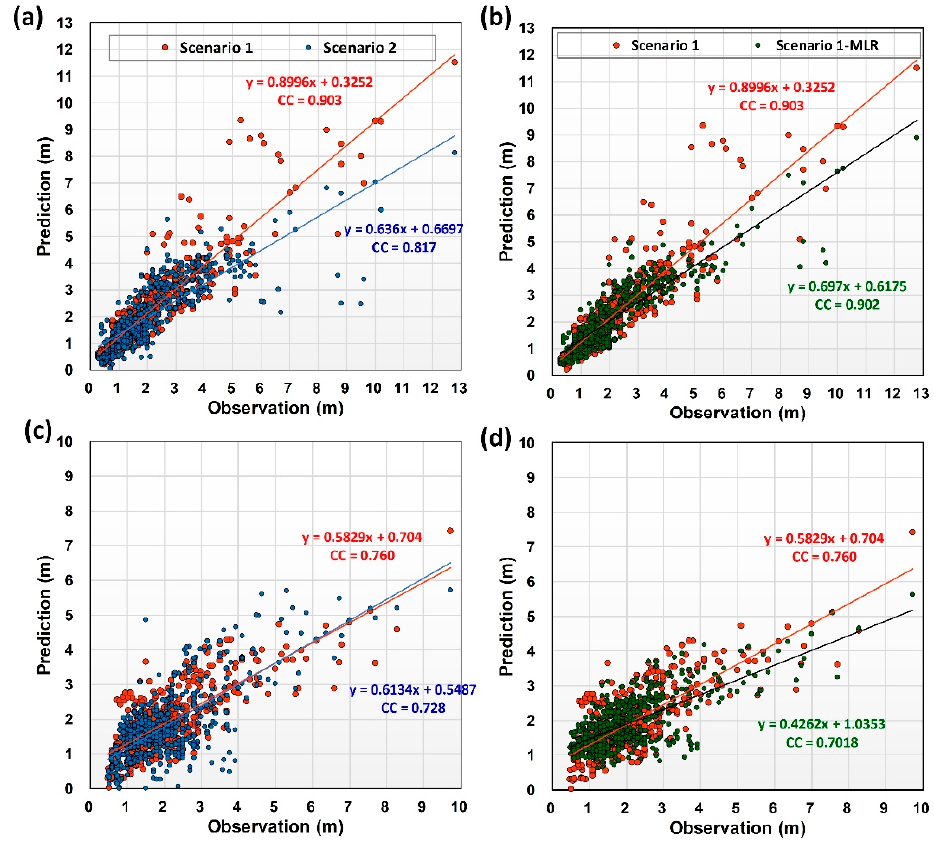
Figure 7. X–Y distribution diagram of wave height at a lead time of 1: ( a , b ) Longdong buoy and ( c , d ) Guishandao buoy.